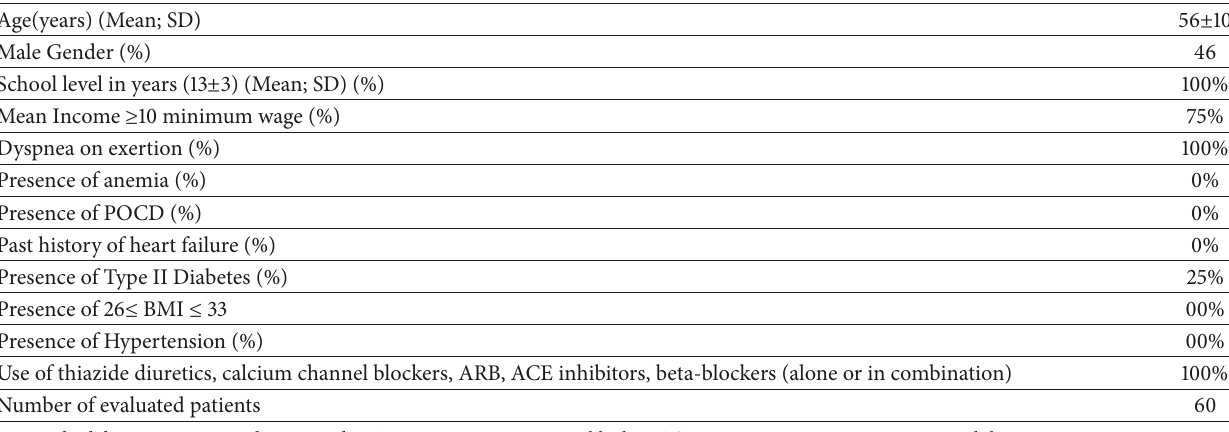
Table 1: Sociodemographic and clinical data.